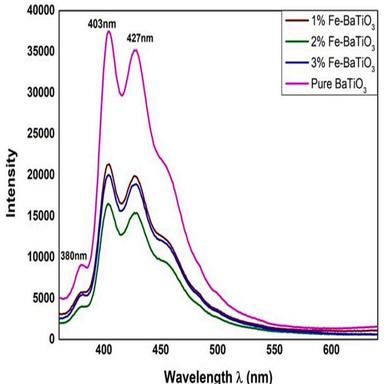
Photoluminescence spectra of pure and doped BTO samples.